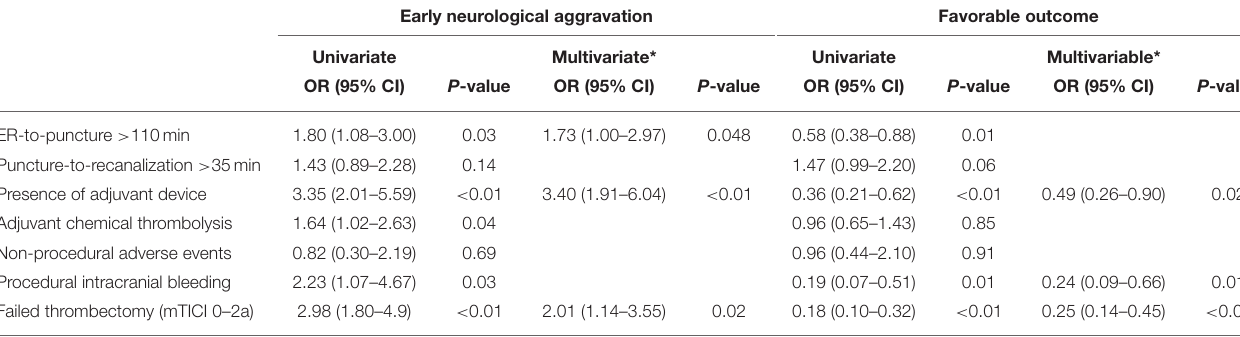
Supplementary Figure 2 demonstrates the association between the TAB-TICI score and accumulated proportions of outcomes. On the basis of these results, we classified the performance into three grades: excellent (TAB-TICI score 0), fair (TAB-TICI scores 1 and 2), and poor (TAB-TICI scores 3–5). The proportion of early neurological aggravation sequentially increased ( P -value for Kendall tau < 0.01) and that of favorable outcomes decreased ( P -value for Kendall tau < 0.01; Figure 1 with worsening of performance grades from excellent to